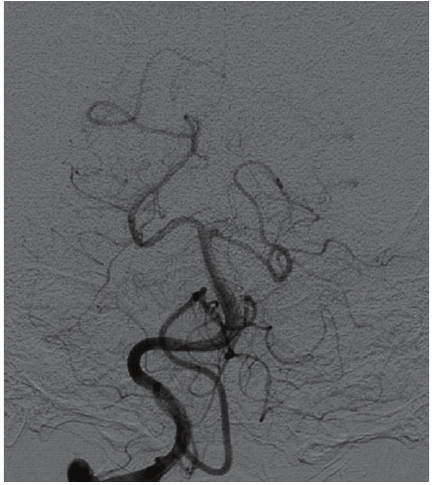
Figure 2: Computed tomographic angiogram showing the azygous A2.